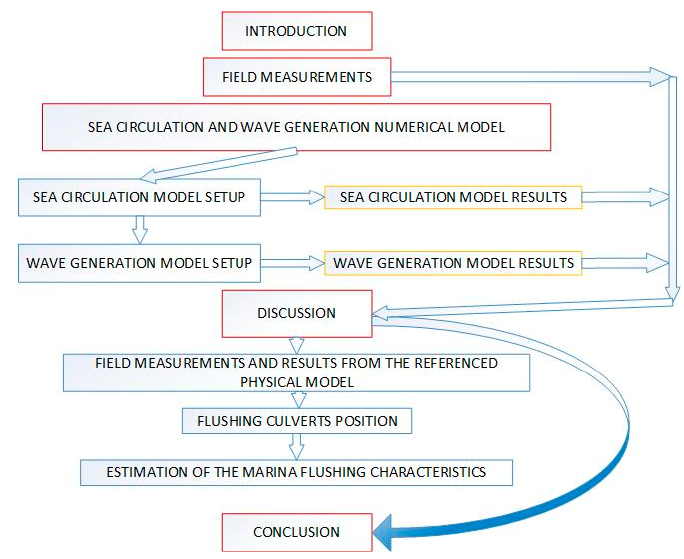
Figure 1. The article flow chart.